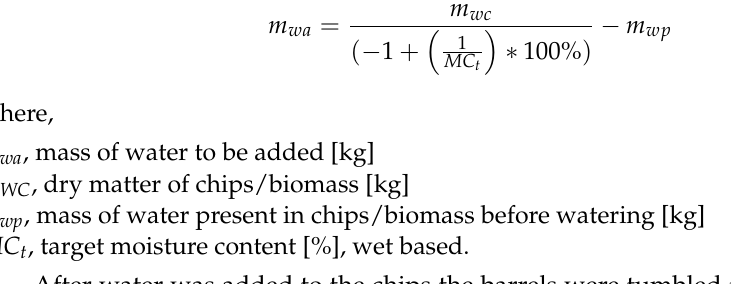
Figure 3. General setup of the water tension measuring box [33].